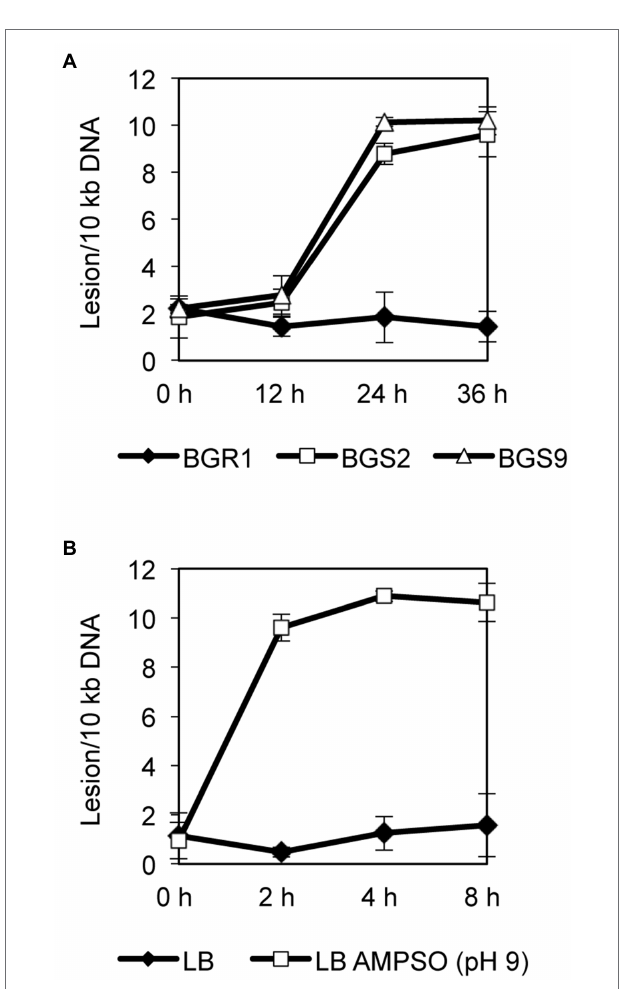
FIGURE 5 | Quantitative analysis of nucleic acid damage. (A) Quantitative PCR assay for DNA damage in wild-type BGR1 and QS mutants in LB broth at 37 ° C. The relative levels of DNA damage were evaluated by comparing the lesion frequency per amplicon between wild-type BGR1 and QS mutants. (B) Quantitative PCR assay for DNA damage in wild-type BGR1 after transfer to LB broth or LB broth buffered with 100 mM AMPSO (pH 9). Data are mean ± SE of triplicate